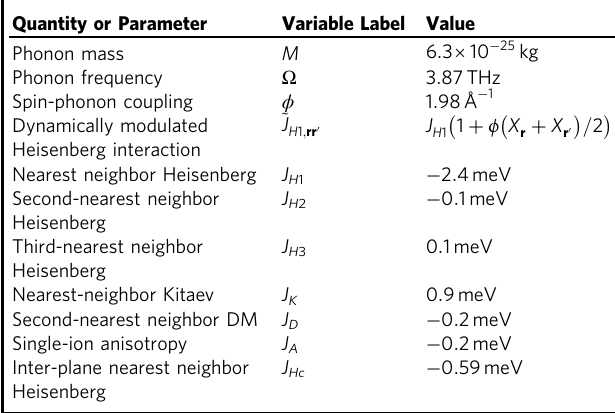
Table 1 Dynamic spin-phonon model properties and static spin exchange